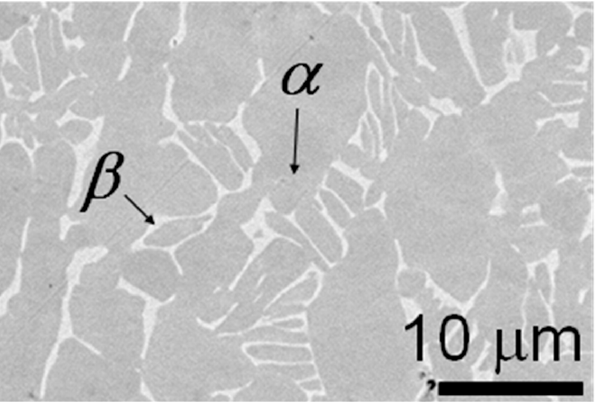
Figure 3. FESEM micrograph view of the Ti-6Al-4V alloy showing the heterogeneous distribution of the α -/ β -phases.